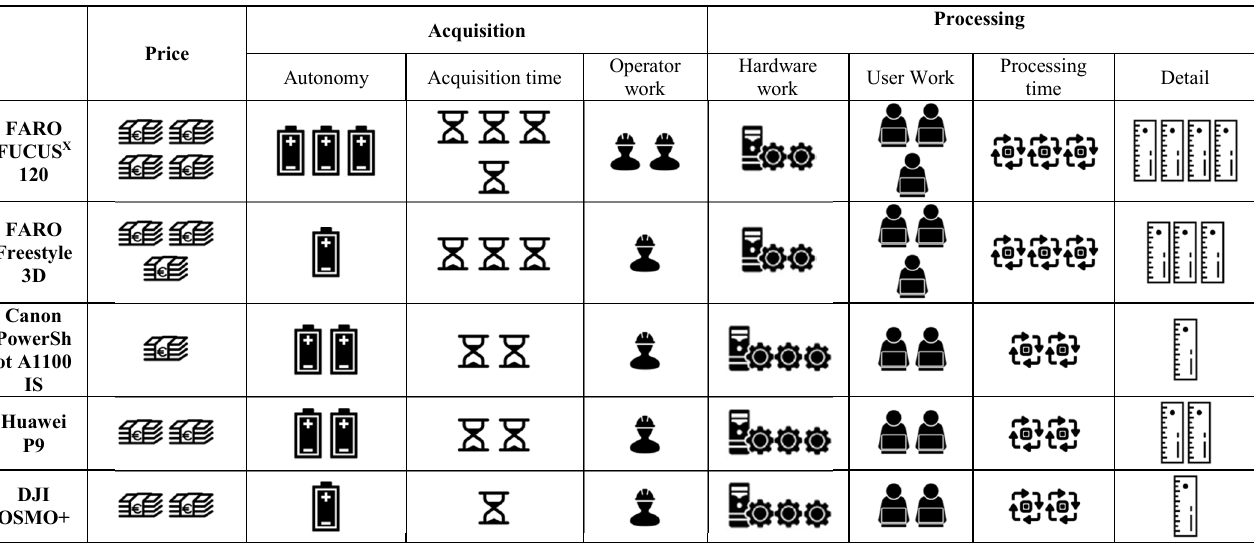
Table 12. Synthetic graphic overview of the many factors involved in a global evaluation of operational efficiency in use and metric accuracy of results about the tested low-cost and COTS